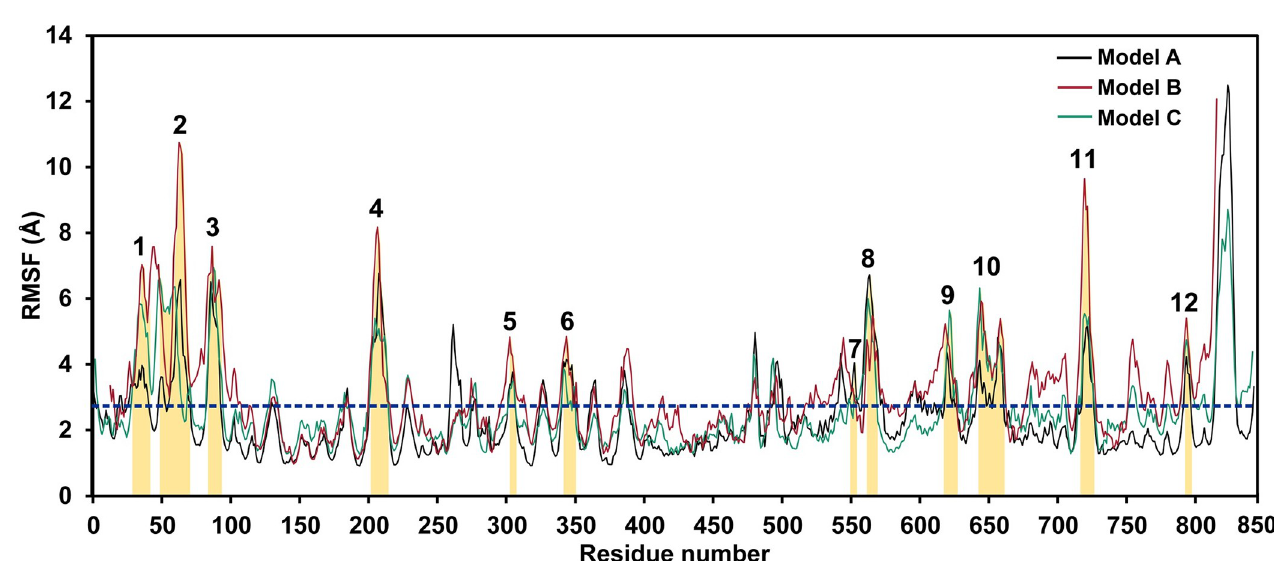
Fig 2. The RMSF plots of model A, B and C demonstrate highly flexible regions. The areas of twelve highly flexible regions were highlighted in orange. The cutoff value for identification of highly flexible regions is showed in blue dotted line.